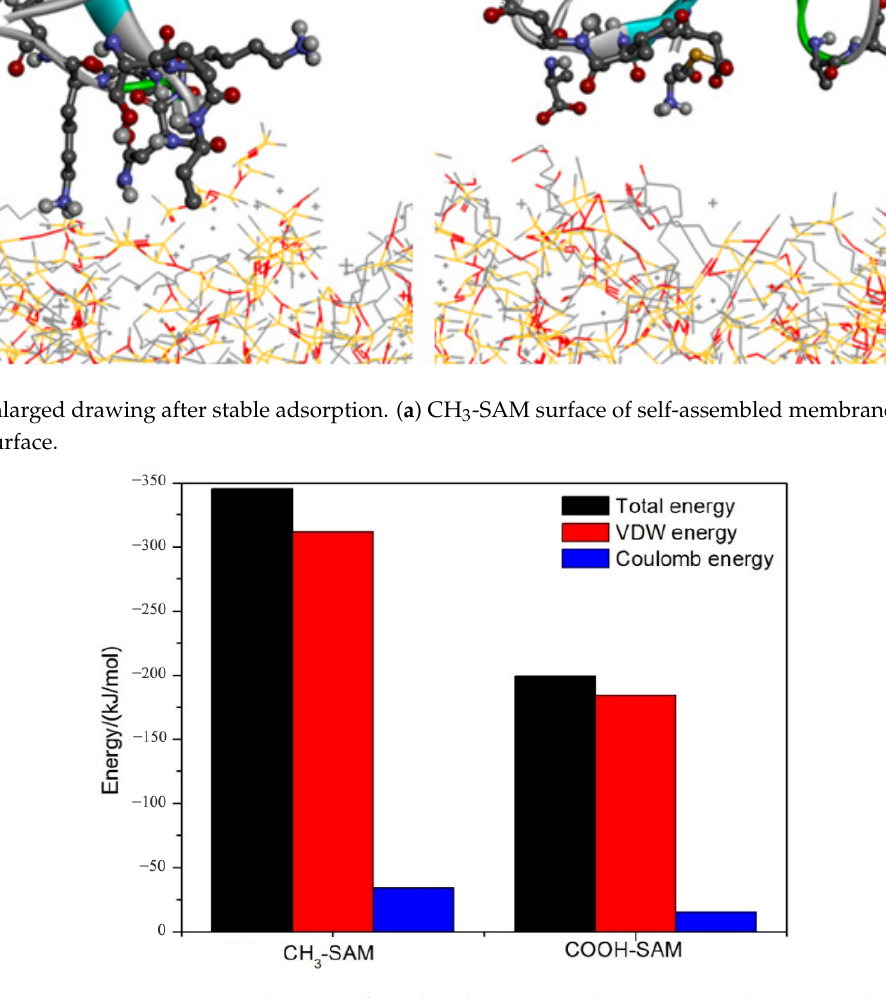
Figure 4. Energy diagram of non-bond interaction between mussel protein and substrate.